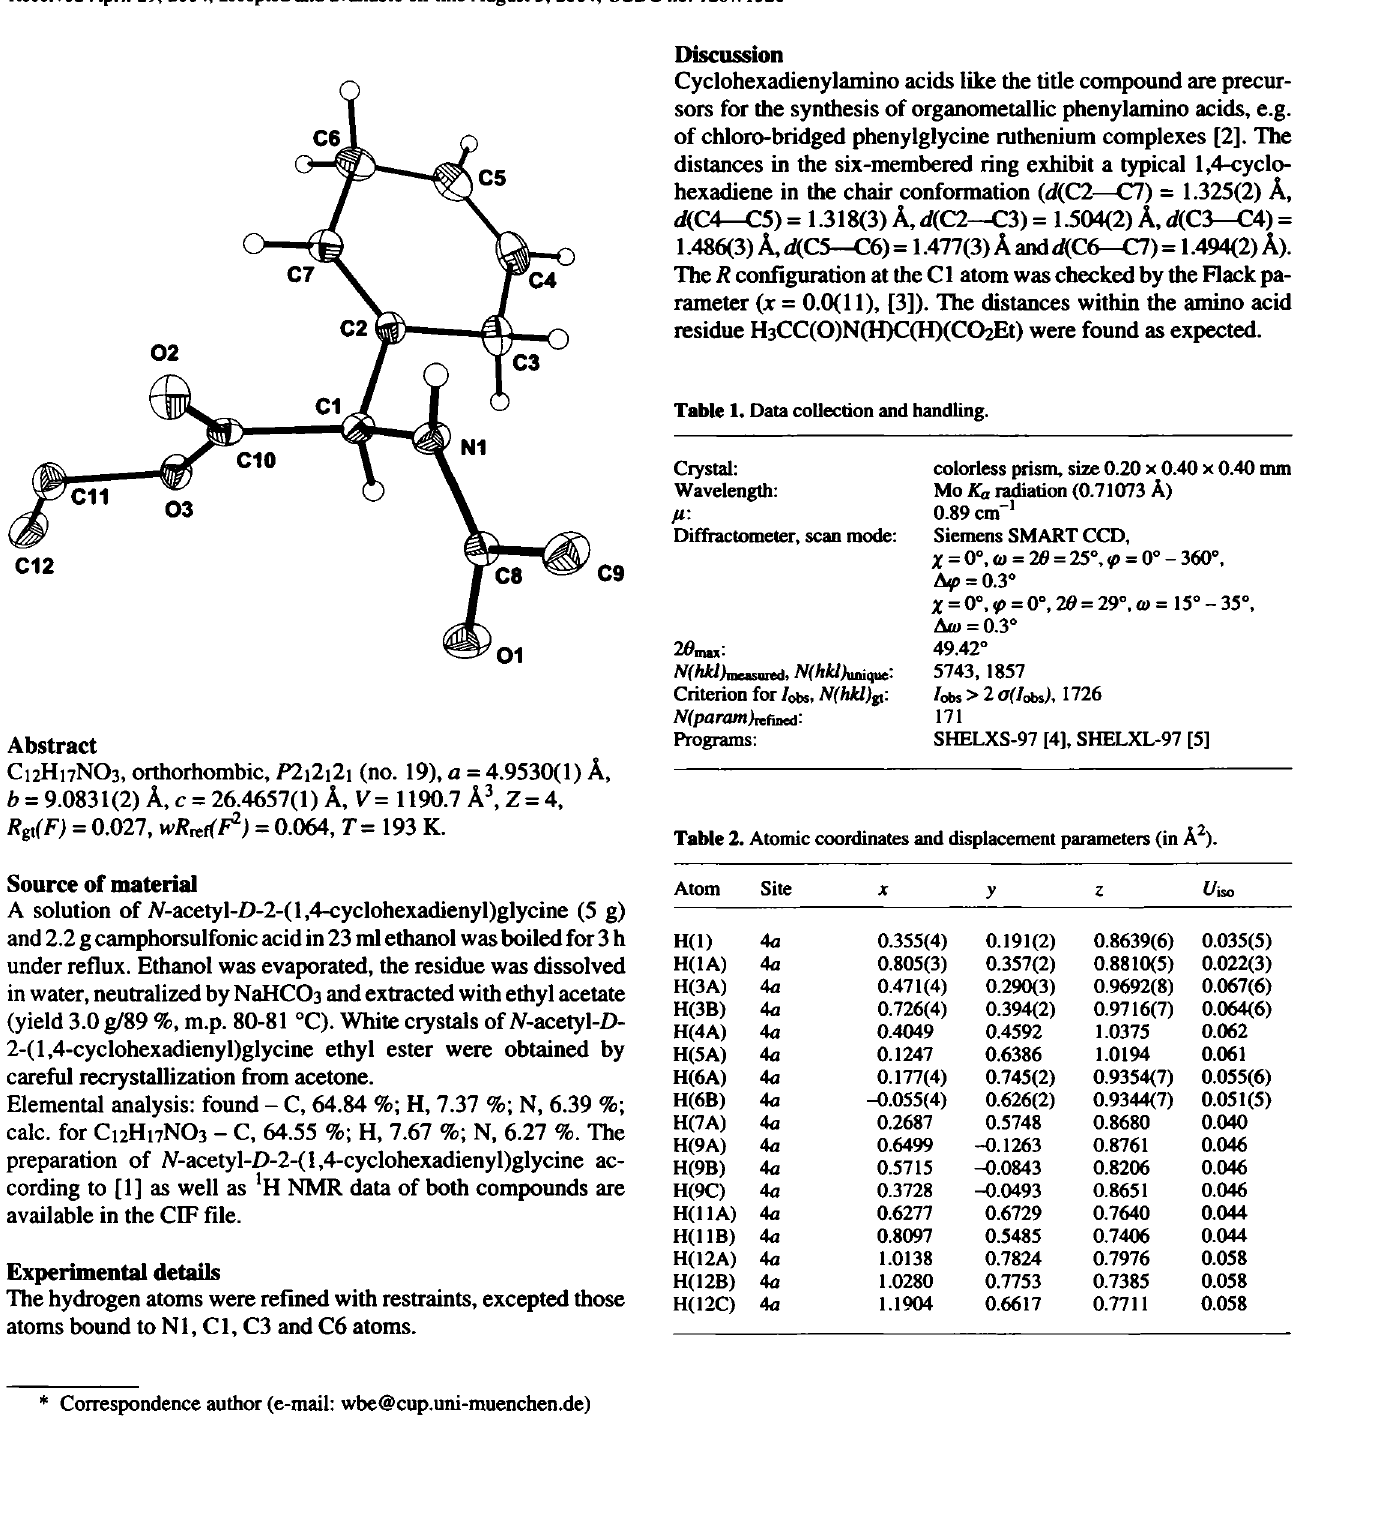
Table 1. Data collection and handling.